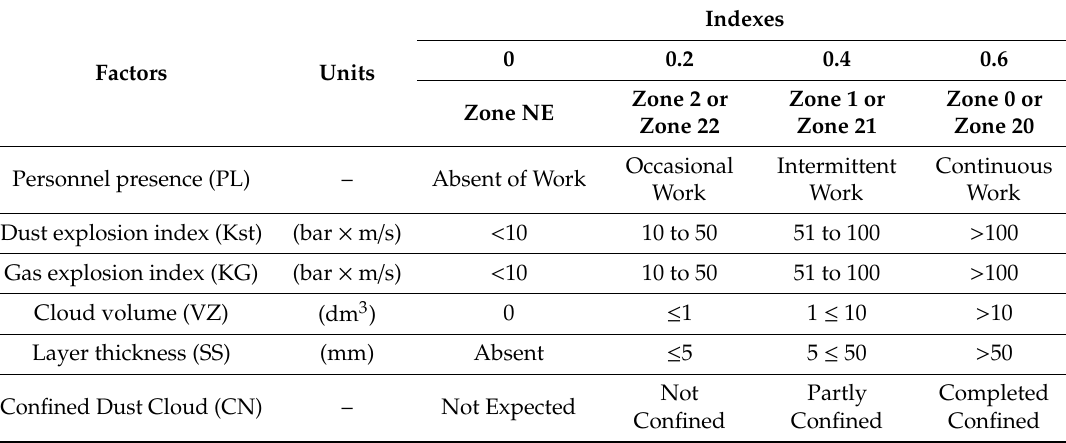
Table 11. Indexes for the D HOF value